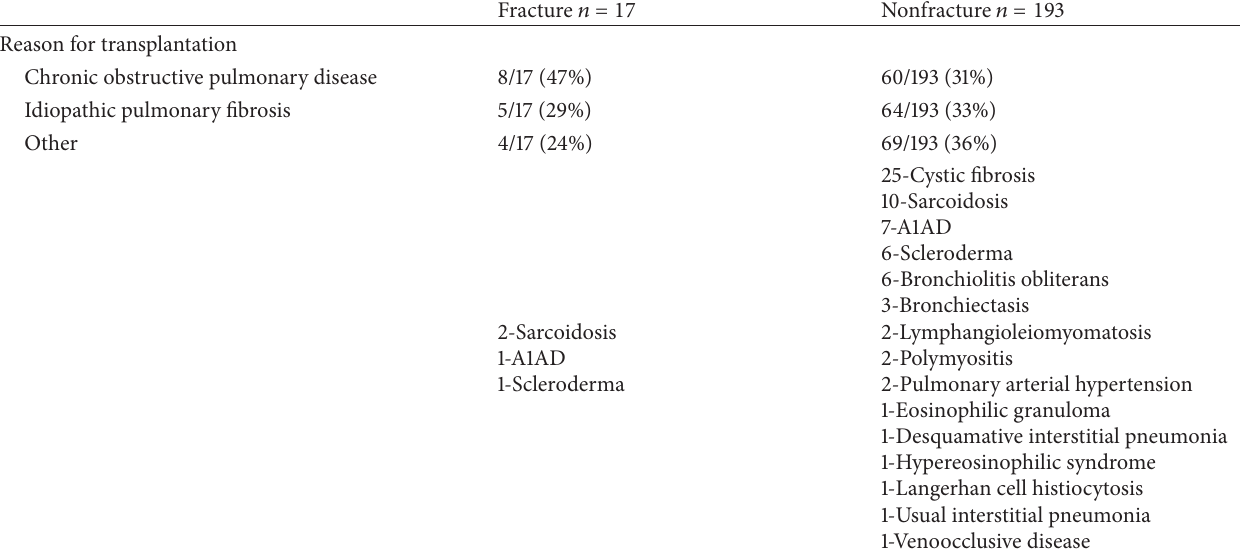
Table 2: Comparison of reasons for transplantation in those with fractures versus no fractures in the lung transplant